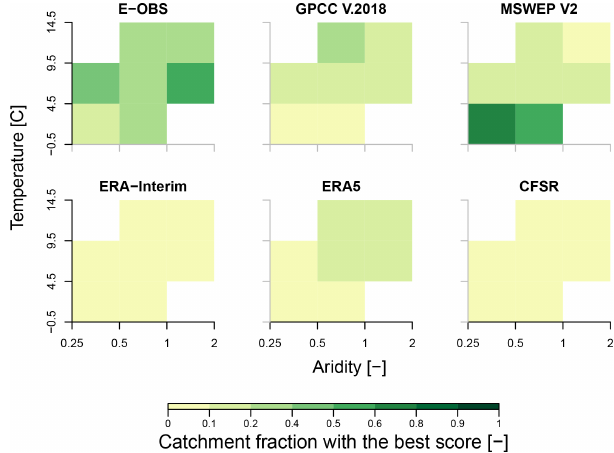
Figure 6. Runoff-based performance of precipitation products across climate regimes. Colors refer to the percentage of catch- ments within each box recognized as the best performance based on anomaly correlation and absolute bias during